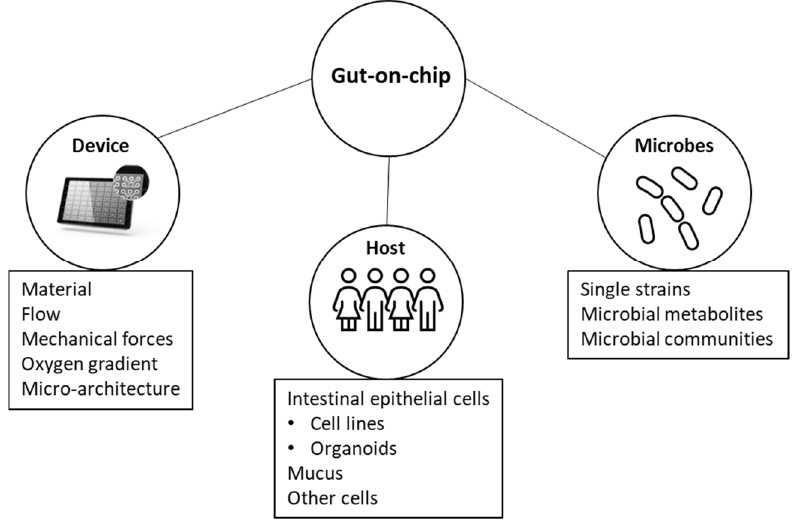
Figure 1. Features of gut ‐ on ‐ chip models to study host - microbial interactions.